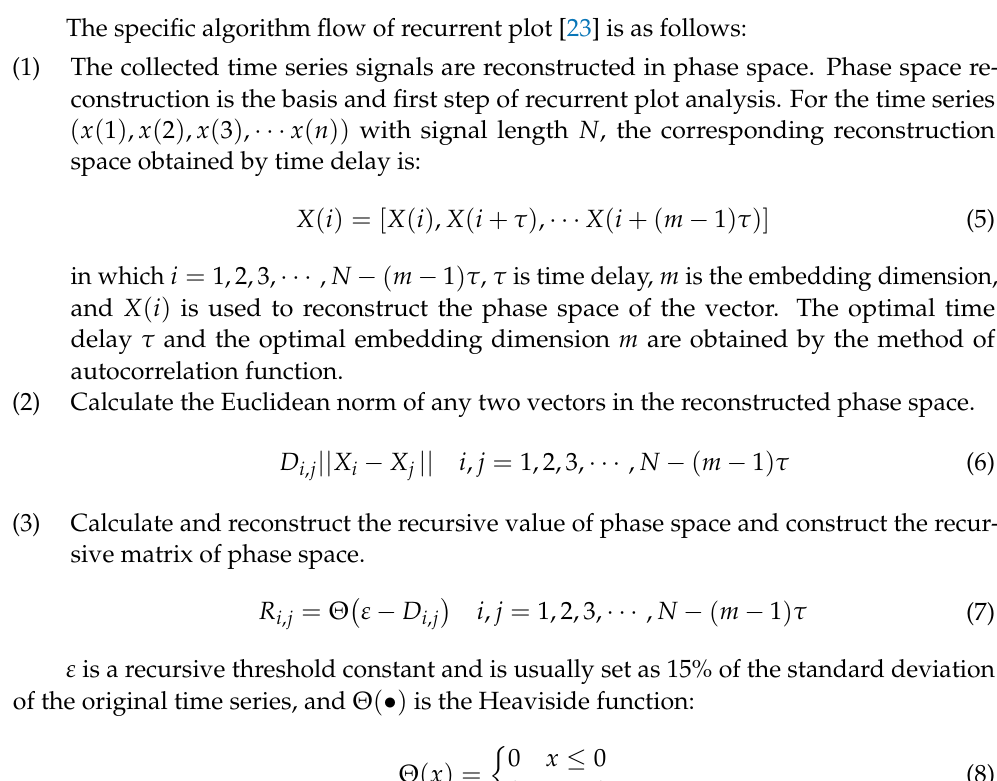
Input image Figure 2. Schematic diagram of residual structure. In order to further improve the feature extraction capability of the residual network and enhance the performance of the deep neural network, this paper proposes a channel split residual network by constructing a channel split (CS) layer instead of the first convo- lutional layer in the original residual network, and the flow chart of the CS layer is shown in Figure 3. Firstly, the 1D bearing vibration signal is converted into a three-channel 2D picture containing the fault characteristics by the picture conversion method, and then the three-channel picture is input to the network for channel splitting, one of the three chan- nels is selected as the primary operation channel, and the other two channels are second- ary operation channels. The channel mixing operation is illustrated in Figure 4. After that, the secondary operation channel is expanded to three channels by convolution. Finally, expanded primary operation channels are stacked n times so that the number of channels Convolution Layer Batch Normalization Layer Activation Function Layer Convolution Layer Batch Normalization Layer Activation Function Layer Output image Identity